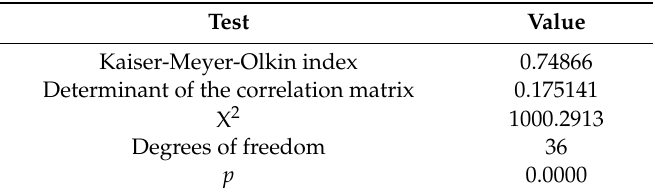
Table 7. Previous principal component analysis (PCA)